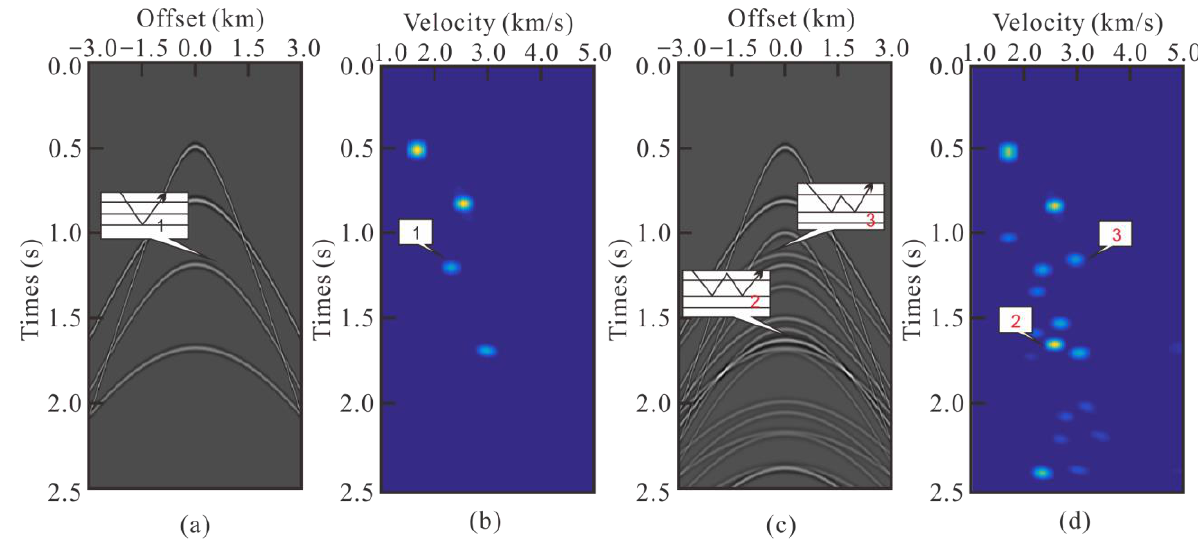
Figure 1. Comparison between seismic data without and with multiples and their velocity spectra, There is a corresponding relationship between event and peak marked with the same number in the figure, where the number 1 is primary, number 2 is surface-related multiple, and number is internal multiple: ( a ) seismic data containing only primaries. ( b ) Velocity spectra corresponding to data ( a ). ( c ) Seismic data containing primaries and multiples. ( d ) Velocity spectra corresponding to data ( c ).